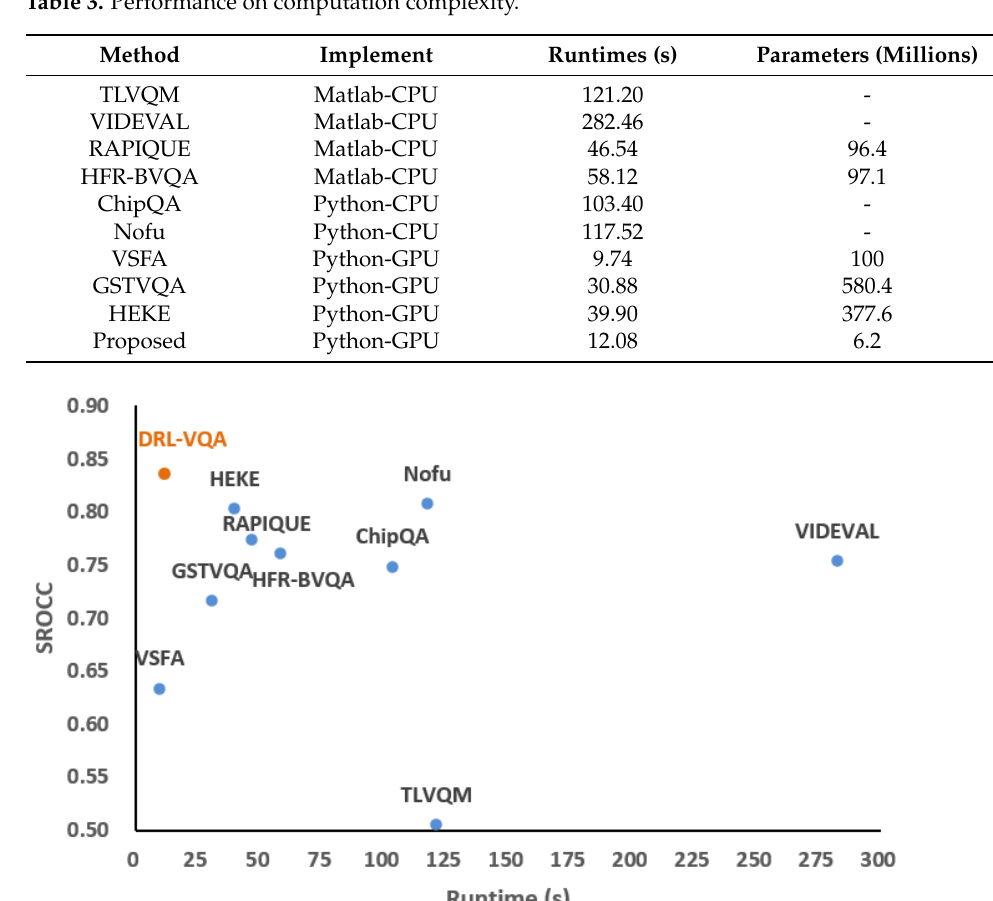
Figure 8. The speed and performance comparison for our model and the other nine BVQA models on the MCML